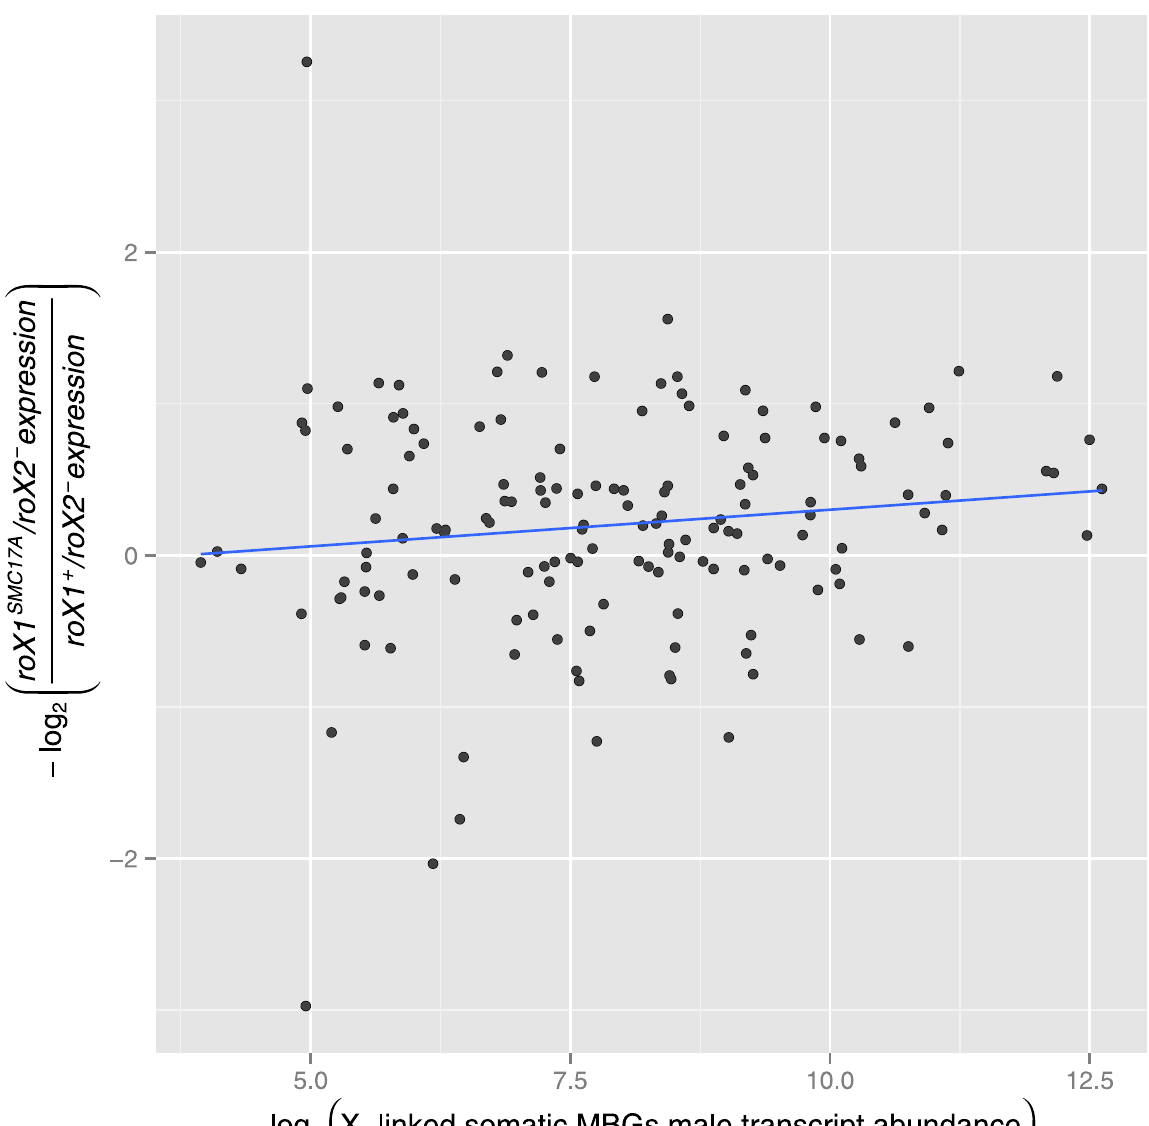
Figure 1. Degree of dosage compensation versus transcript abundance. For X -linked MBGs, a measure of dosage compensation roX 1 SMC 17 A = roX 2 { exp : ) is plotted against and transcript abundance in third instar larval males. No significant linear relationship was found ( { log 2 roX 1 z = roX 2 { exp : ( R ~ 0 : 13, p § 0 : 05 ).